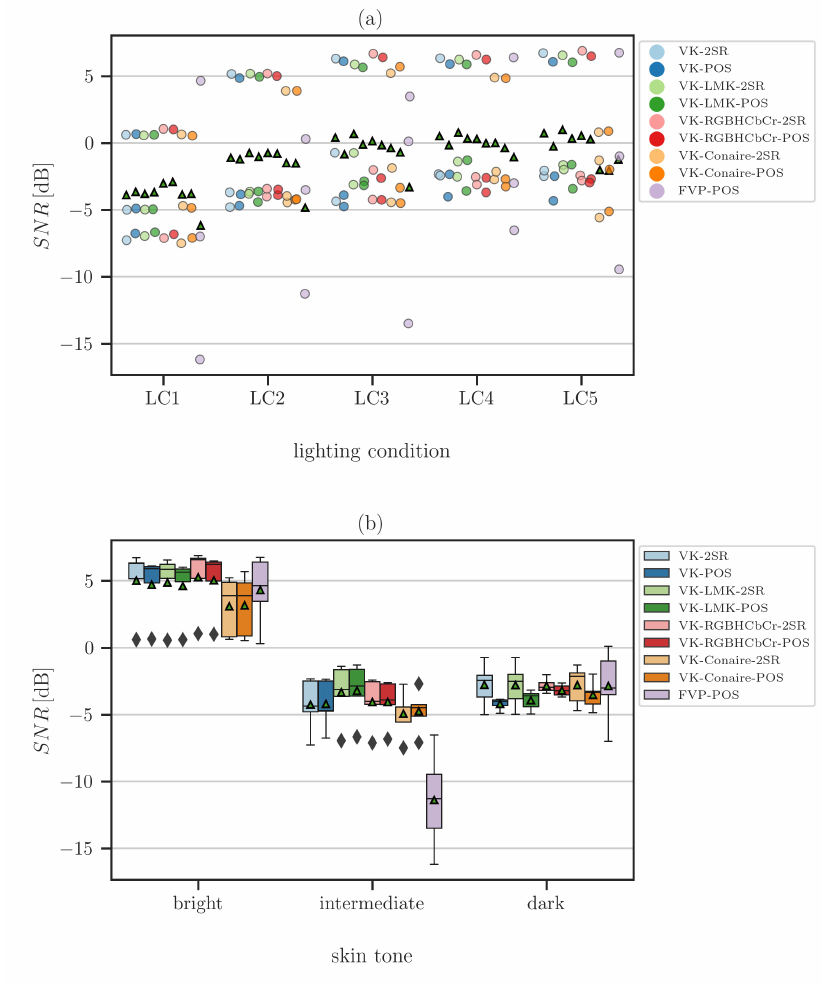
Figure 3. Performance of the studied approaches with and without image processing front-end in combination with two rPPG algorithms (POS and 2SR) in terms of SNR on the example of PBDTrPPG covering ( a ) different lighting conditions (LC1: 0.052 × 10 2 lux, LC2: 0.363 × 10 2 lux, LC3: 1.870 × 10 2 lux, LC4: 7.200 × 10 2 lux, LC5: 27.200 × 10 2 lux) and ( b ) skin tone challenges.